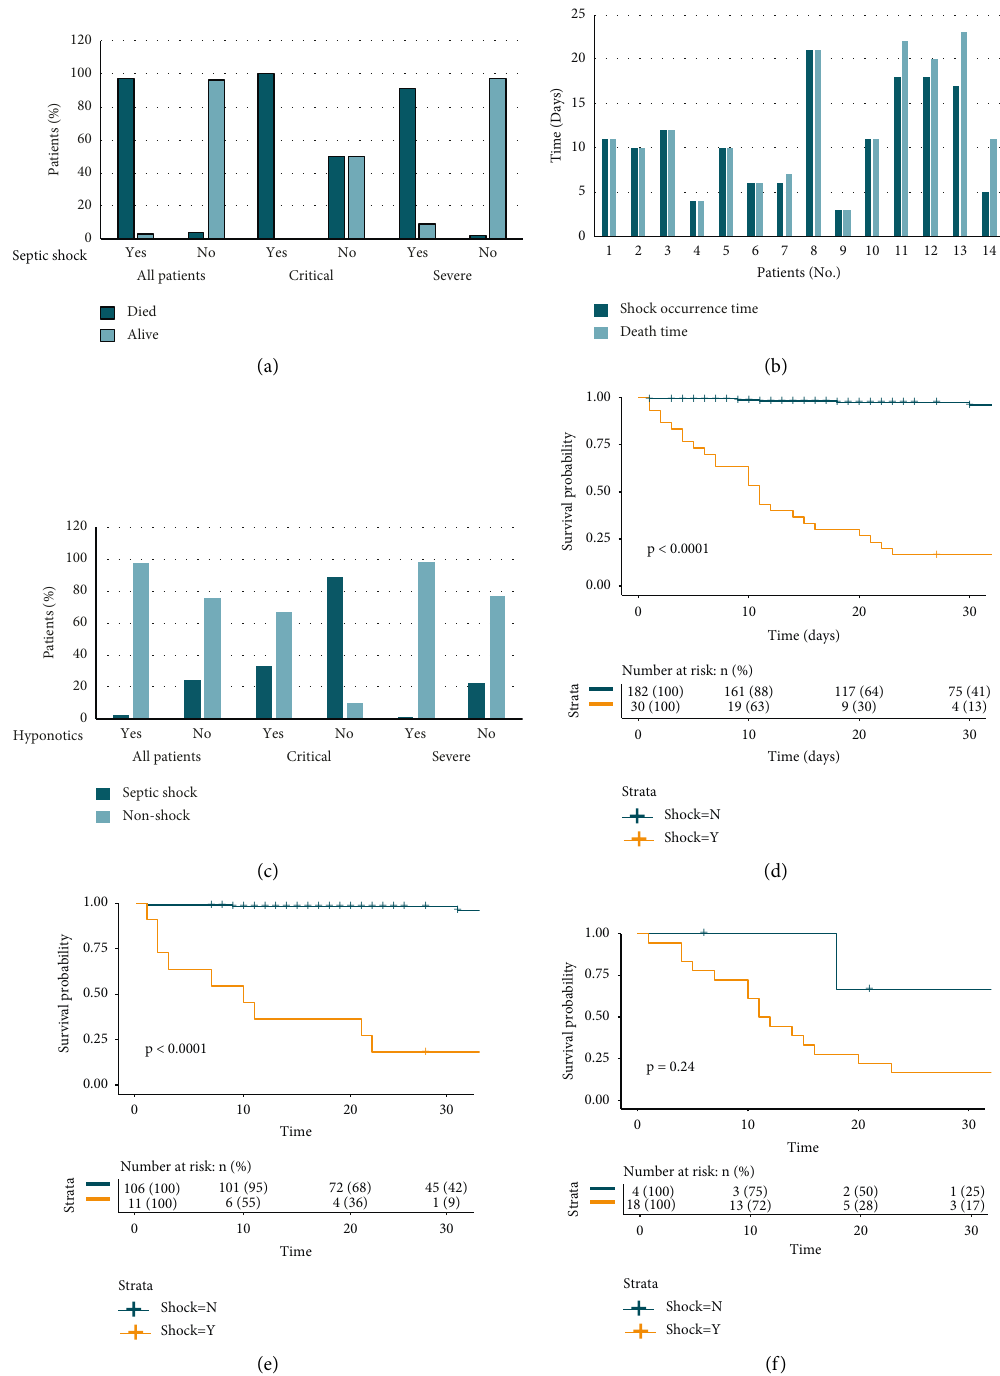
Figure 1: Clinical outcomes and survival analysis. (a) Clinical outcomes of COVID-19 patients with septic shock in all patients, in severely ill patients, and in the critically ill group. The survival rates are calculated by the survival of individual patients divided by the entire number of patents in each group. (b) Time to onset of septic shock and time to death after hospitalization, 9 patients had the same duration of septic shock following onset and time to death; the longest interval was 6 days in patient number 14 (some patients had no clear onset of septic shock); No, Number. (c) The septic shock occurrence rates of patients who took hypnotics shown in critical and severe categories. (d) Kaplan–Meier curve of COVID-19 patients with septic shock including all patients; patients in the nonseptic shock had significantly better survival rates ( p < 0 . 0001). (e) Kaplan–Meier curve of COVID-19 patients without septic shock had significantly better survival rates in the severe group ( p < 0 . 05). (f) Kaplan–Meier curve of COVID-19 patients with septic shock had a trend toward worse survival rates in the critical group ( p < 0 .